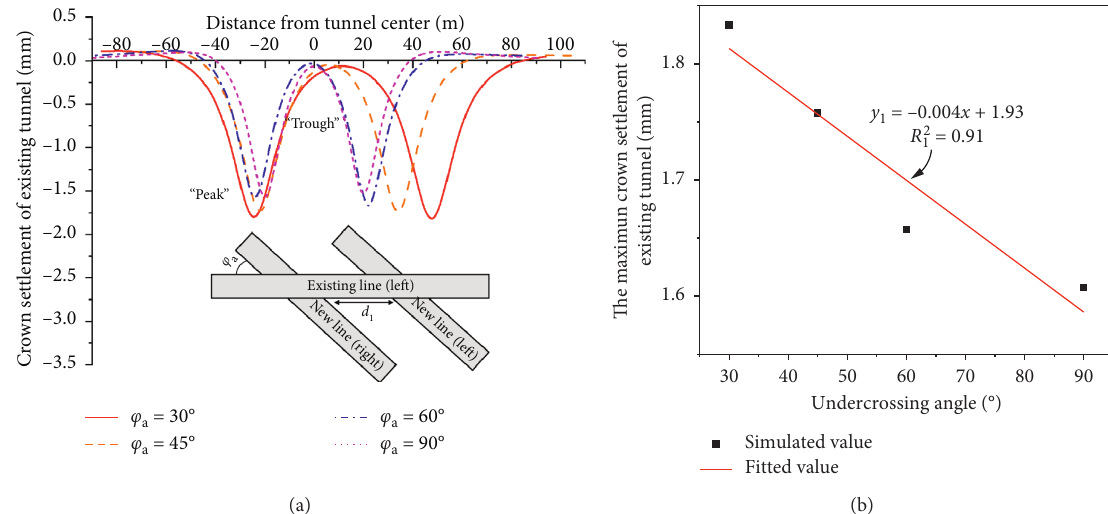
Figure 12: The crown settlement of existing tunnel with the undercrossed angle variation. (a) The settlement curves of the existing tunnel. (b) The linear fitting of the maximum settlement value of the existing tunnel.